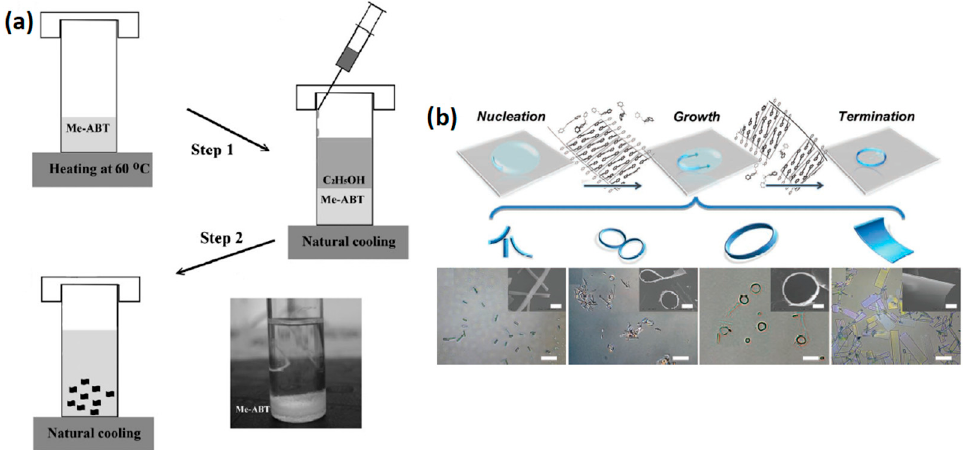
Figure 5. ( a ) Illustration of self-assembly process of 6-methyl-anthra[2,3- b ]benzo[ d ]thiophene (Me-ABT) through solvent exchange method. Reproduced with permission from ref. [69]. Copyright 2010, Wiley-VCH. ( b ) Diagram of the mechanism form which micro-rings are self-assembled by interfacial tension of liquid drops. Reproduced with permission from ref. [72]. Copyright 2013, Wiley-VCH.